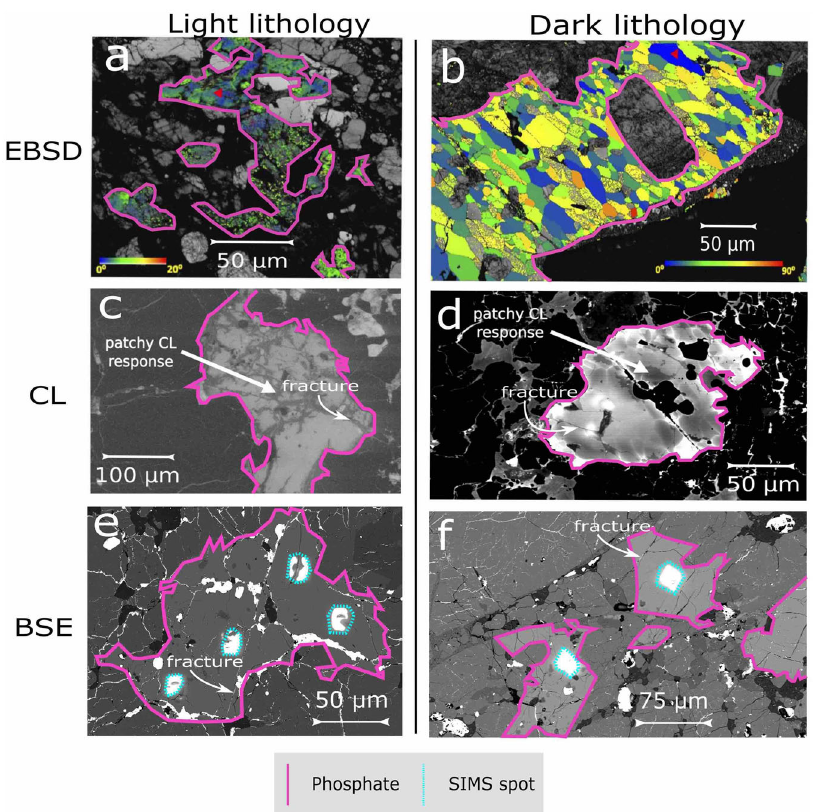
Fig. 2 Mineral microtextures in Chelyabinsk. In EBSD images, colour-scheme indicates crystal lattice misorientation relative to an arbitrary point (red triangle). a apatite grain showing smooth gradations in lattice misorientation, revealing strain and associated deformation. This strain was most plausibly accumulated during impact. b merrillite grain with distinct subgrains of uniform and unstrained crystal lattice orientation, revealing recrystallisation that likely developed in response to more extensive heating. c apatite showing patchy CL response, correlated with fractures. d merrillite showing subgrain recrystallisation, as well as overprinting patchy CL response correlated with fractures. e apatite showing extensive fracturing. Metal and sul fi de veins (white in BSE image) fi ll some fractures, whereas others are un fi lled. f apatite grain showing similar fracturing, proximal to a shock melt-vein. Partially annealed metal and sul fi de veins are abundant in the silicate matrix. In all images, phosphates are outlined in purple. Pole fi gures and further data related to panels a and b are available in Supplementary Fig.